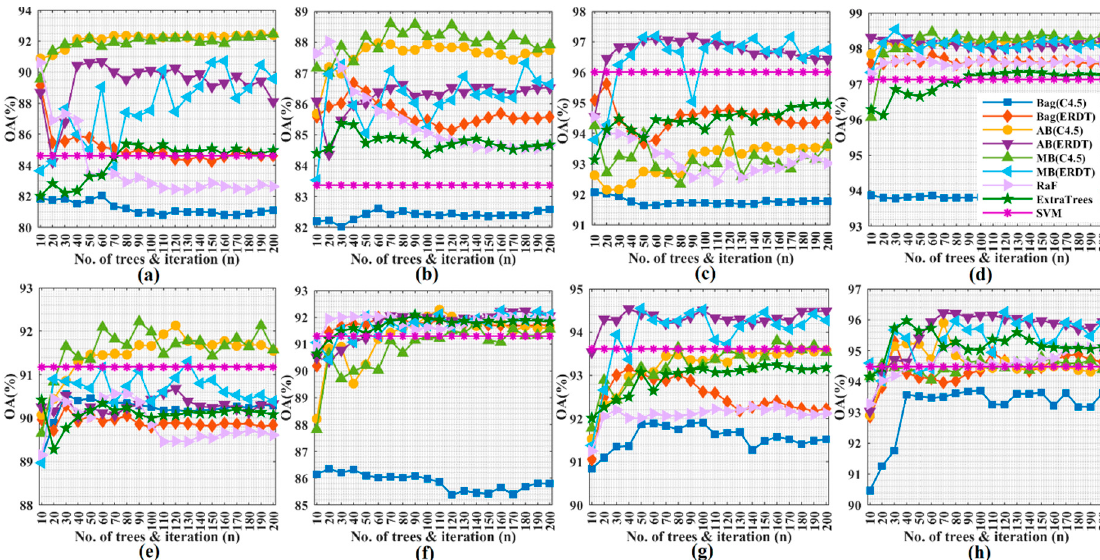
Figure 5. OA values versus the number of trees/iterations in bagging (Bag(C4.5), Bag(ERDT)), AdaBoost (AB(C4.5), AB(ERDT)), MultiBoost (MB(C4.5), MB(ERDT)), RaF(C4.5) and ExtraTrees using MPs ( a , e ), MPPR ( b , f ), object-guided morphological profiles (OMPs) ( c , g ) and OMPsM ( d , h ) from PCA-transformed features of Pavia University ( a – d ) and GRSS-DFC2013 ( e – h ) data sets.